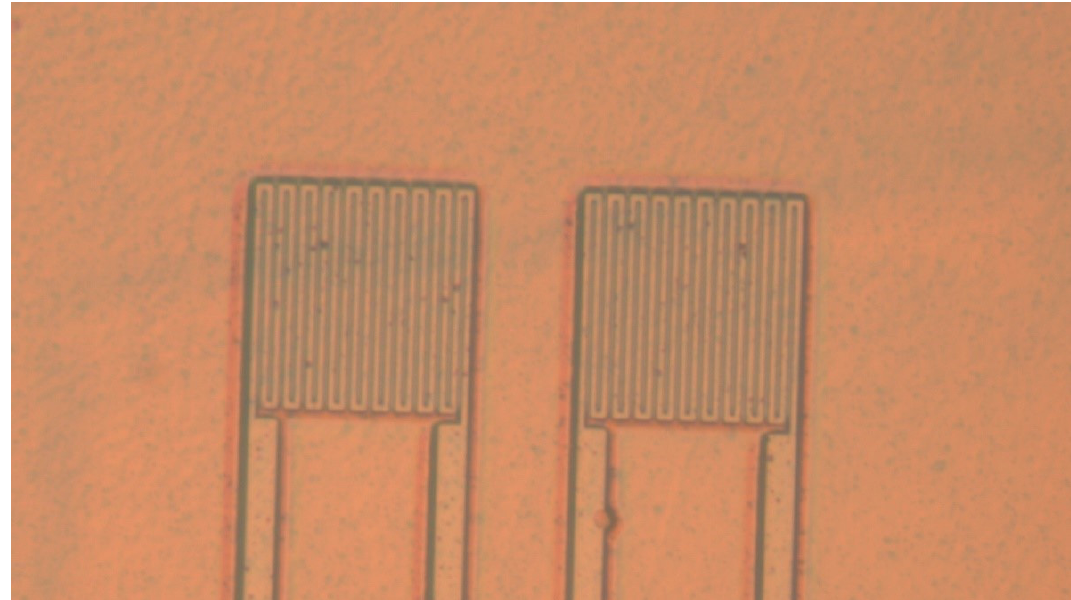
Figure 4. Electrode pattern after development.